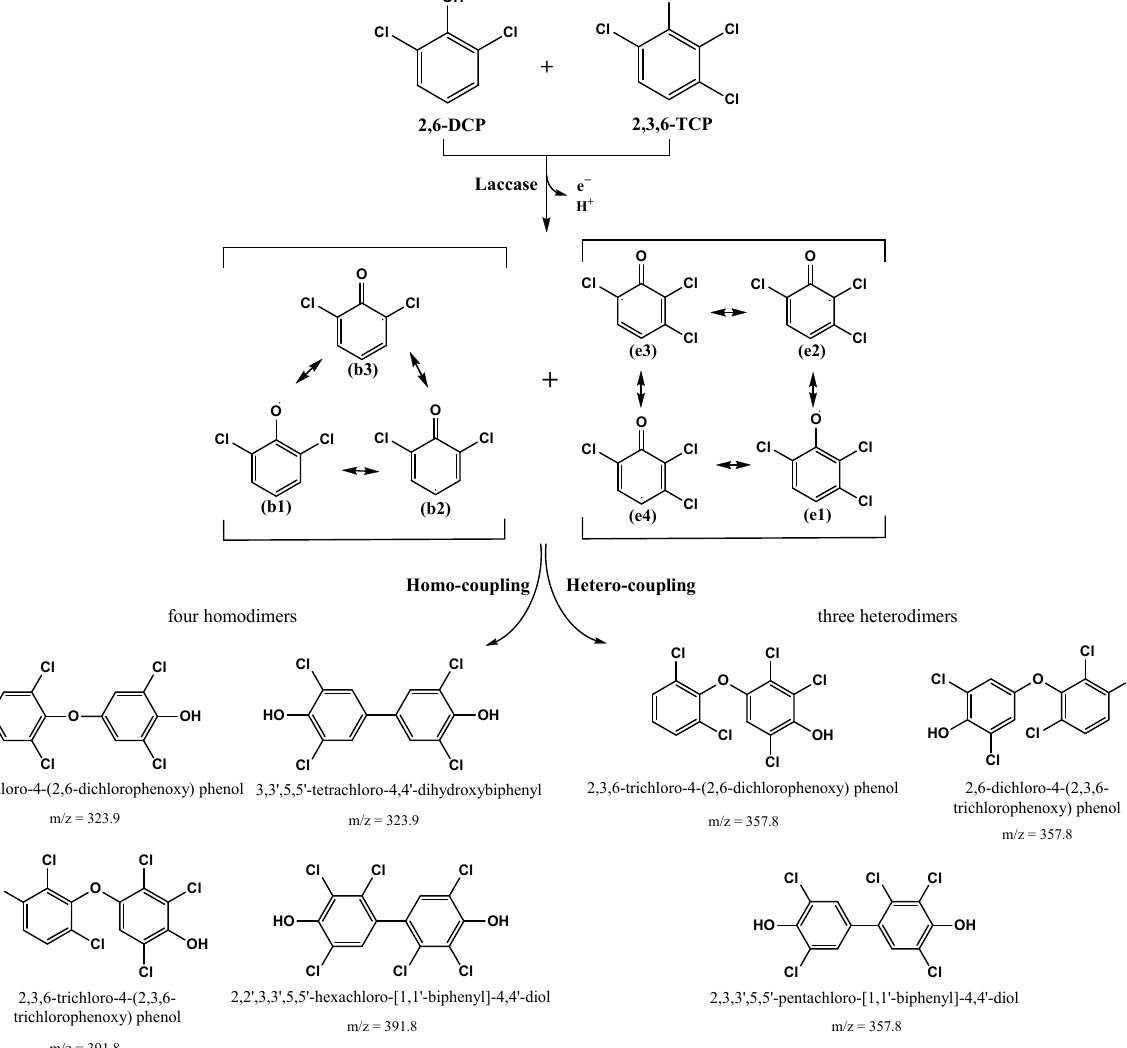
Figure 17. The degradation products of an equivalent mixture of 2,6-DCP and 2,3,6-TCP catalyzed by LAC-4 laccase contain four homodimers and three heterodimers.